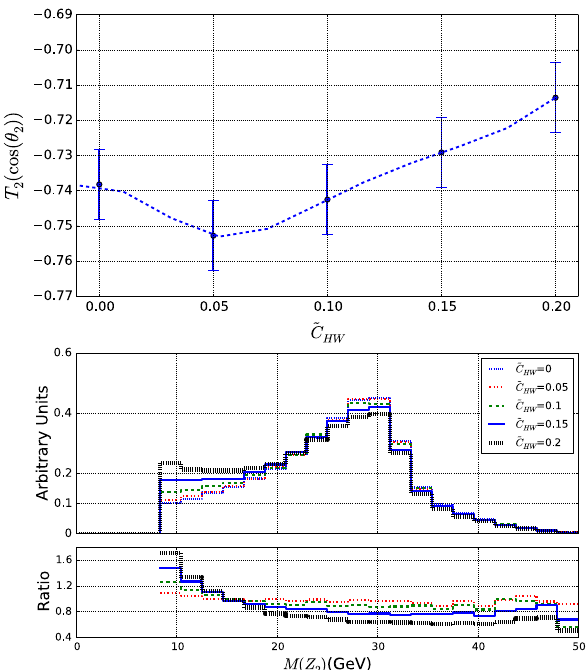
Fig. 12 Representative kinematical properties of the four-lepton sys- tem originating from a Higgs boson that is decaying into a Z -boson pair and that has been produced in LHC collisions at a center-of-mass energy of 13 TeV. We consider the T 2 ( cos θ 2 ) variable as defined in the text and present its dependence on the ˜ c HW parameter, together with the one of the off-shell Z -boson invariant-mass distribution (bottom), for varied ˜ c HW values. In this last case, we also show, in the lower inset of the figure, the bin-by-bin ratio of the new physics predictions to the Standard Model